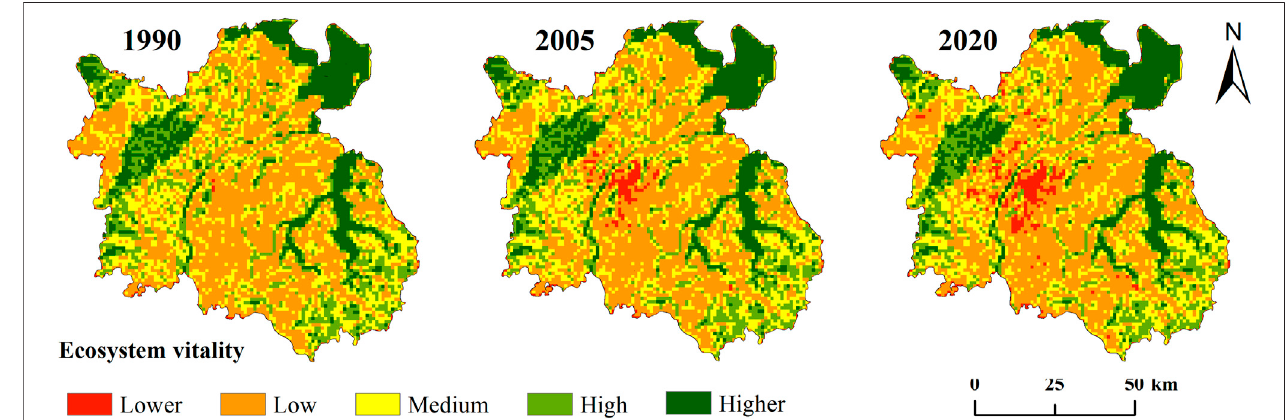
FIGURE 7 | Spatial distribution pattern of ecological elasticity in 1990, 2005, and 2020.